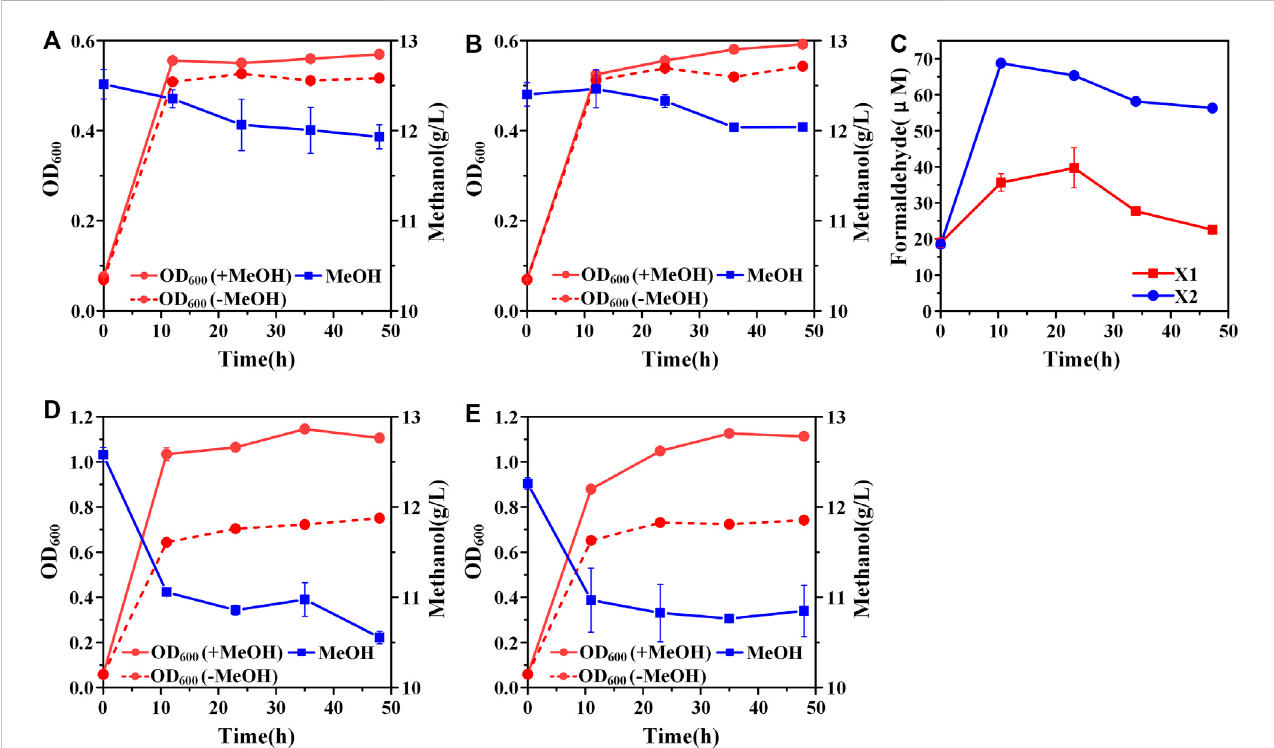
FIGURE 2 Construction of the hybrid methanol assimilation pathway. (A) Growth characteristics of strain X1; (B) Growth characteristics of strain X2; (C) formaldehyde accumulation. Addition of amino acids mix solution could improve cell growth and methanol consumption of both strain X1 (D) and strain X2 (E) . Error bars represent standard deviation, n = 2.